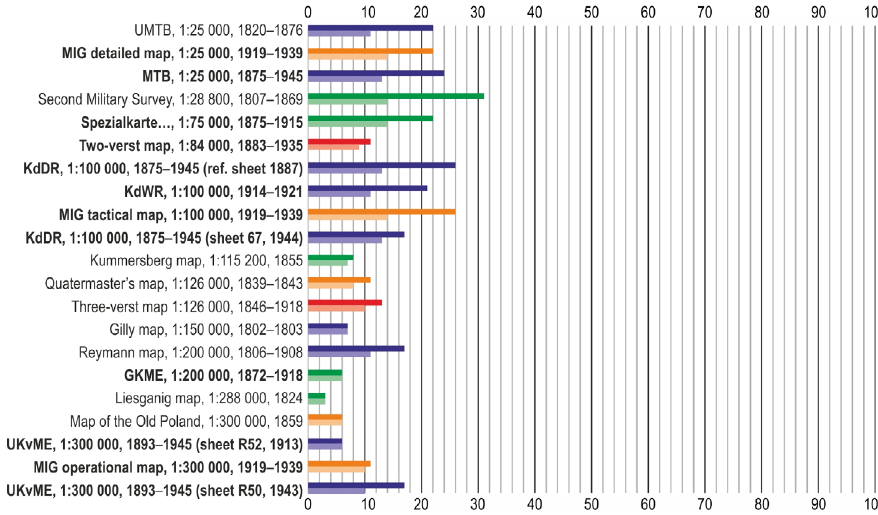
Fig. 4. Number of feature types on different maps’ key to symbols among “land cover” feature class category (before and after